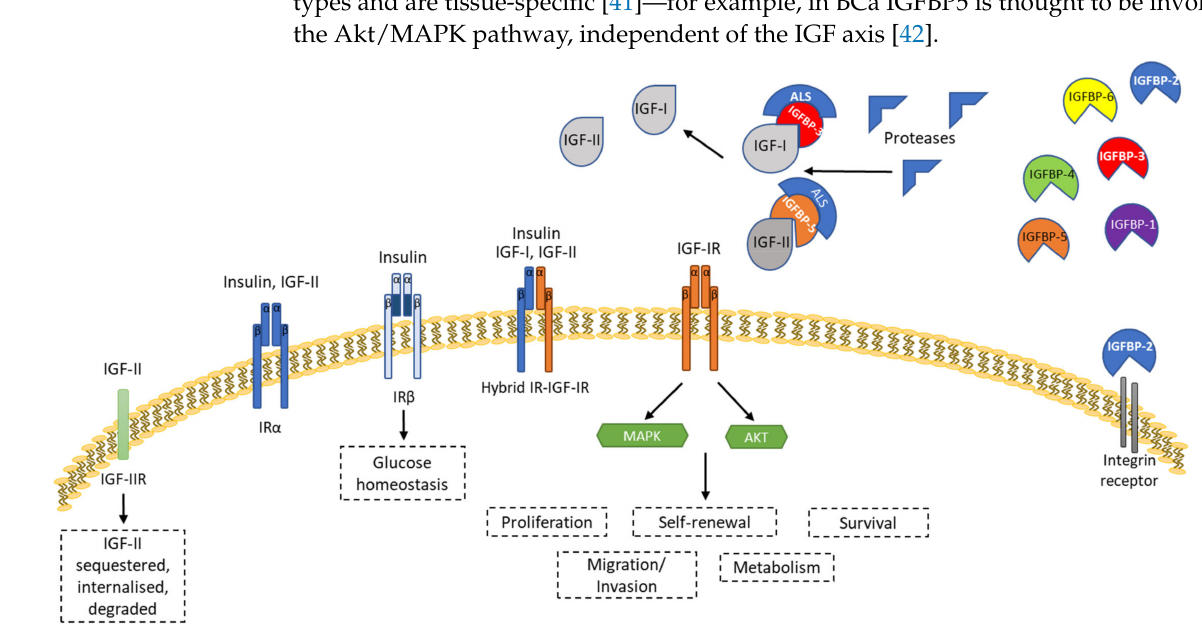
Figure 2. Overview of the intracellular signalling of the IGF system. At the cellular level, IGF-I, IGF-II, and insulin ligands interact with a family of signalling tyrosine kinase receptors: the IGF-IR and the insulin receptor IR, which exists in two alternatively spliced isoforms (IR α and IR β ). IR β has a high affinity for insulin, whereas IR α has a high affinity for IGF-II. Upon the binding of the ligands to the receptors, a signalling cascade is initiated, resulting in the activation of the PI3K/Akt/mTOR/S6K and Grb2/SOS/Ras/Raf/MEK/ERK pathways. Such a cascade culminates in increased cell proliferation, survival, self-renewal, homeostasis, and metabolism. IGFs in the circulation are transported in combination with IGFBP-3 or -5 and an acid labile sub-unit (ALS) that increases their half-life. IGFs are released from IGFBPs -3 and -5 through the action of proteases. There are six high-affinity IGFBPs [1–6] that can act in either an IGF-dependent or independent manner. IGFBPs can interact with different cell surface molecules to exert their IGF-independent effects—for example, integrin receptors or ‘putative’ IGFBP